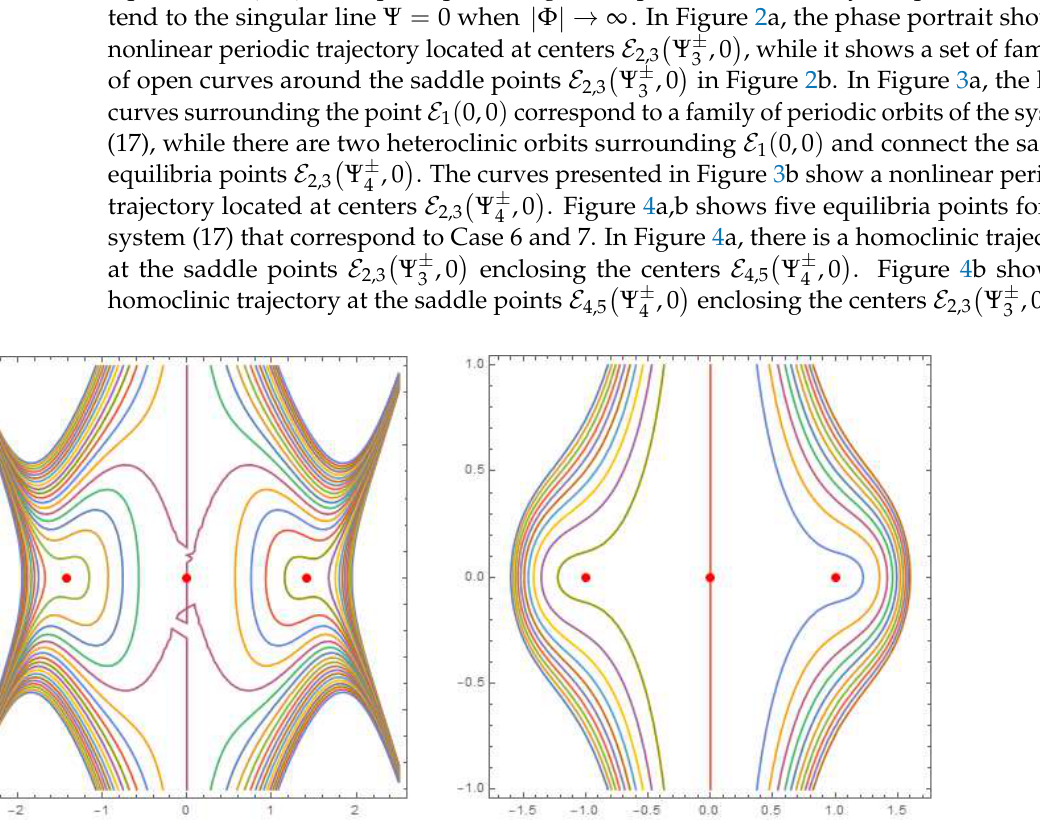
( b ) Figure 2. Trajectories of the dynamical system (17), where ( a ) 𝑎 1 = 1,𝑎 2 = 0,𝑎 4 = 0,𝑞 1 = 1,𝑞 2 = 1,𝑞 3 = 1,𝛾 = 1,𝛿 = 1,𝛽 = 1; ( b ) 𝑎 1 = 1,𝑎 2 = 0,𝑎 4 = 0,𝑞 1 = 1,𝑞 2 = 1,𝑞 3 = −1,𝛾 = 1,𝛿 = 1,𝛽 = 1 .